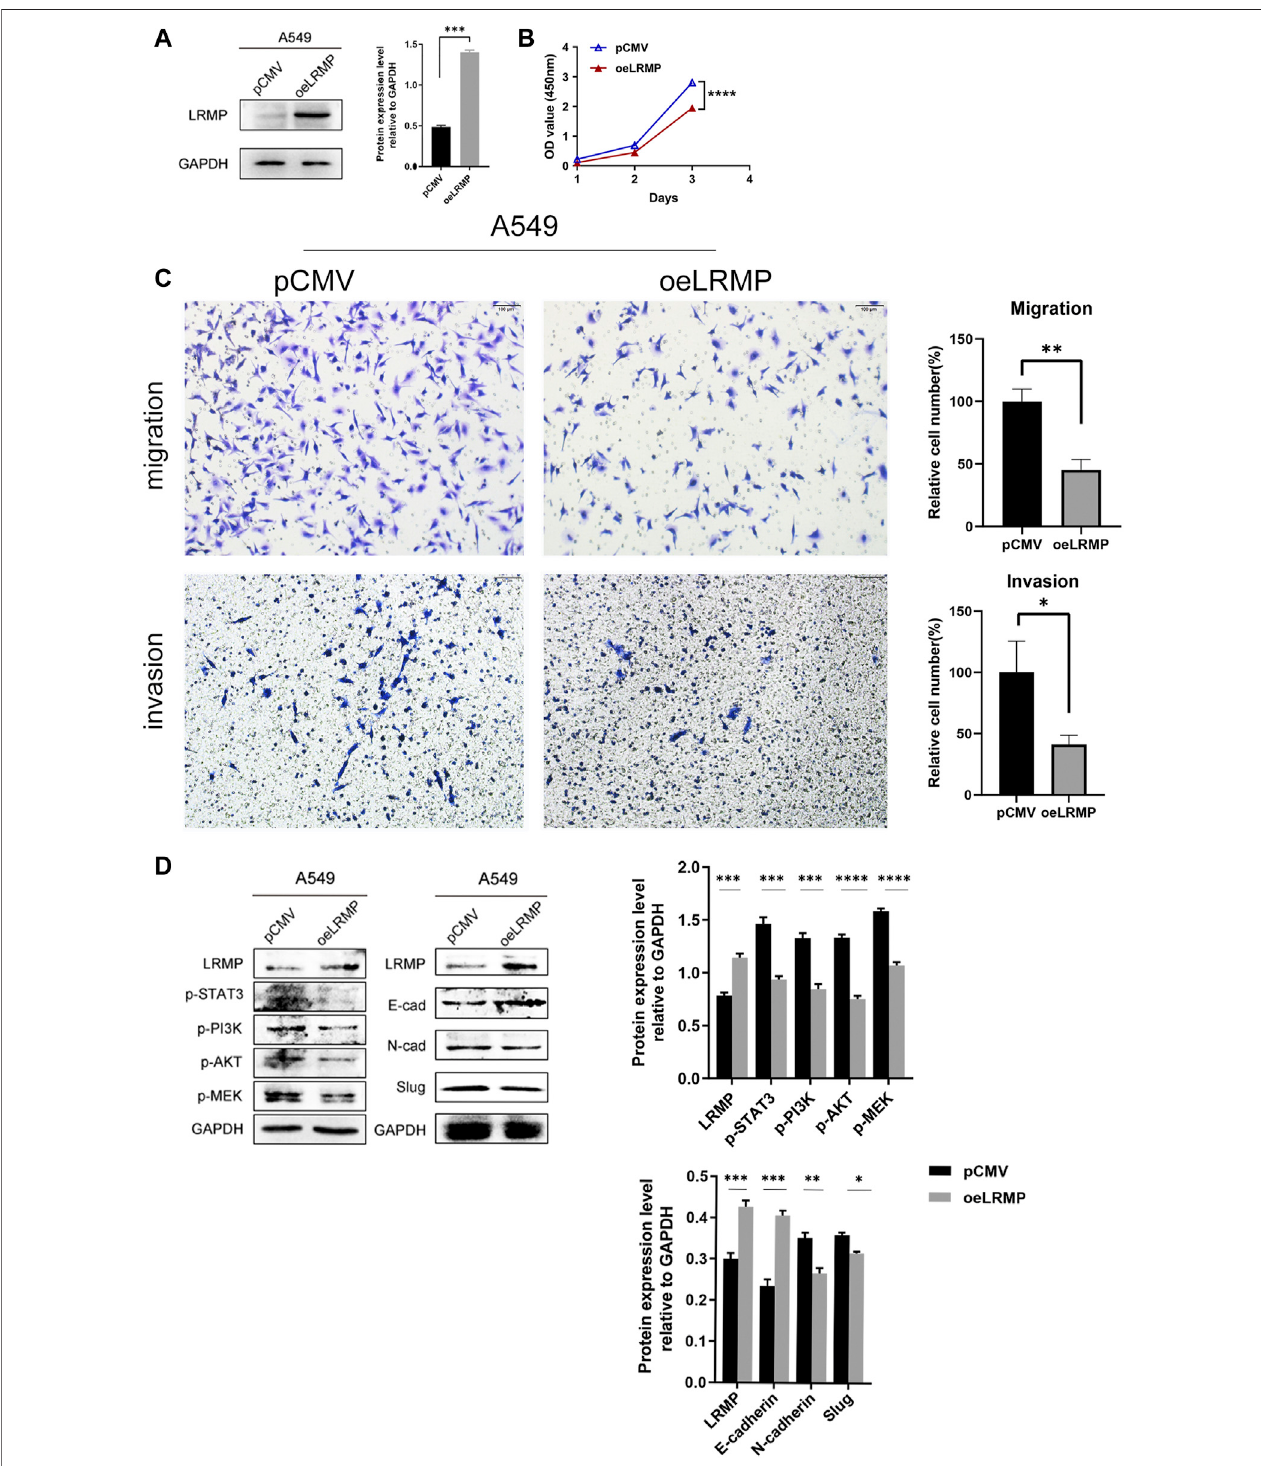
FIGURE5| Functionalveri fi cationandsignalingpathwayanalysisofLRMPinA549cellline. (A) ConstructionofLRMPoverexpressionA549. (B – C) LRMPinhibited the proliferation, migration and invasion. (D) LRMP overexpression downregulated p-PI3K/p-AKT, p-STAT3, p-MEK and EMT signaling pathways by western blotting.